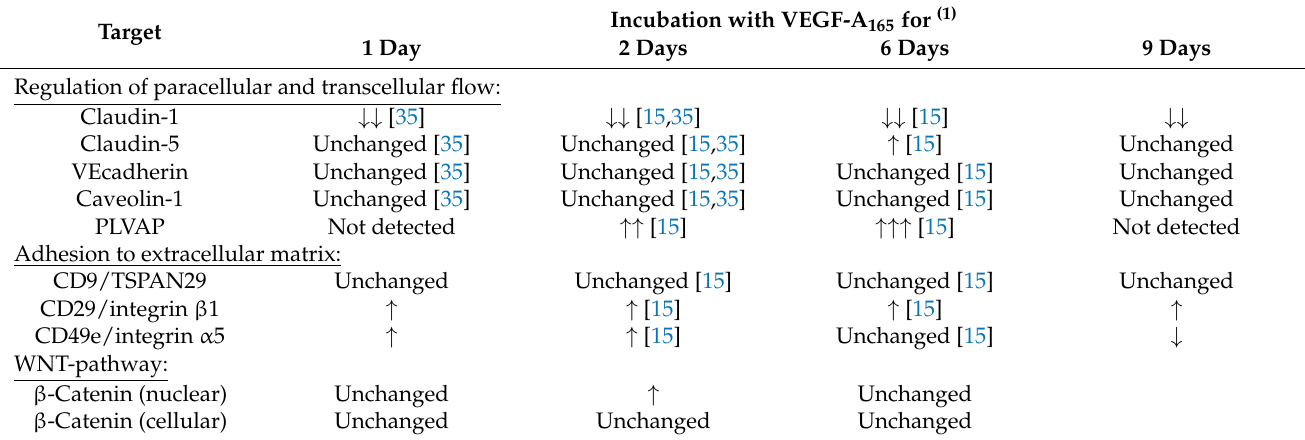
Table 4. Responses of iBREC to VEGF-A 165 depend on exposure time: changes of protein expression levels compared to cells not exposed to the growth